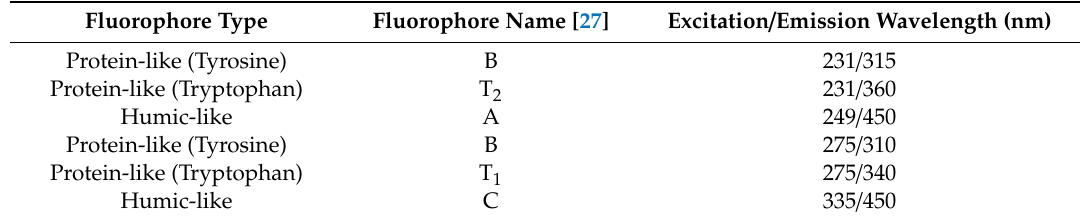
Table 1. Excitation / emission wavelength pair for fluorophores, based on Spiliotopoulou et al. [26]. Fluorophore